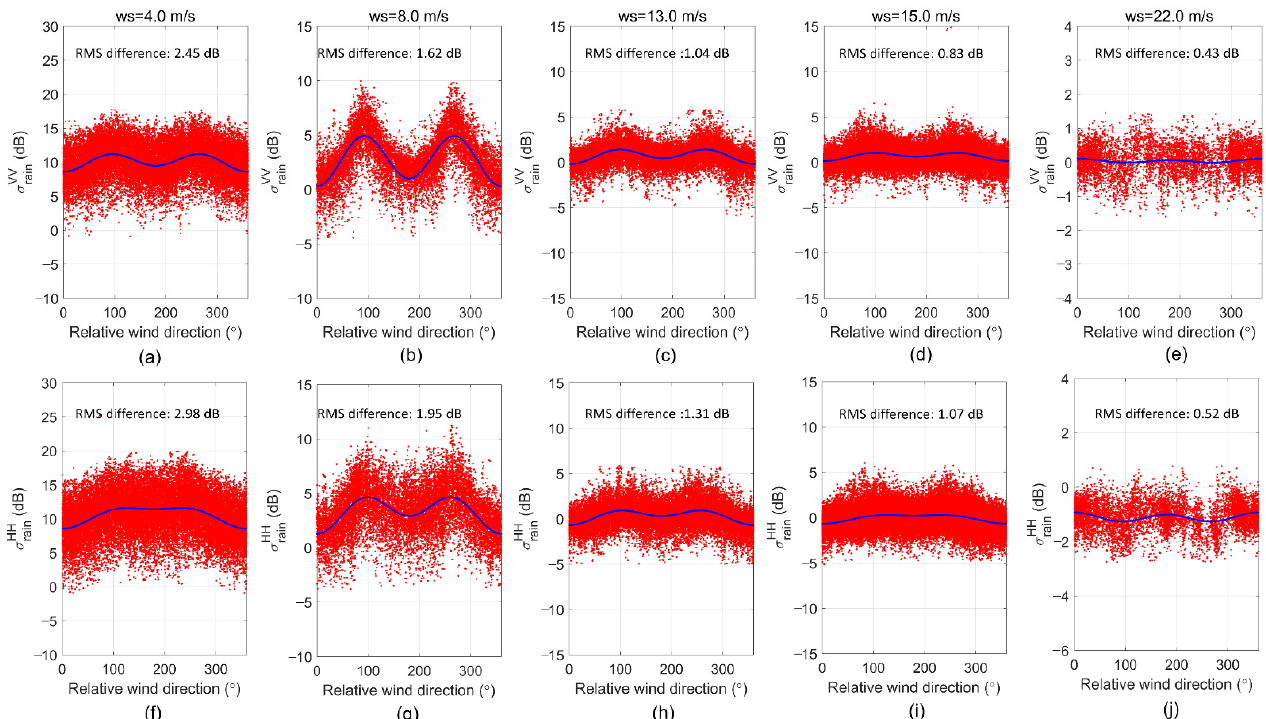
Figure 4. The rain backscatter measurements (red scatters) and the corresponding fitting curves (blue line) versus the relative wind direction for VV (top row) and HH polarization (bottom row): ( a ) 4.0 m/s at VV polarization; ( b ) 8.0 m/s at VV polarization; ( c ) 13.0 m/s at VV polarization; ( d ) 15.0 m/s at VV polarization; ( e ) 22.0 m/s at VV polarization; ( f ) 4.0 m/s at HH polarization; ( g ) 8.0 m/s at HH polarization; ( h ) 13.0 m/s at HH polarization; ( i ) 15.0 m/s at HH polarization; ( j ) 22.0 m/s at HH polarization.